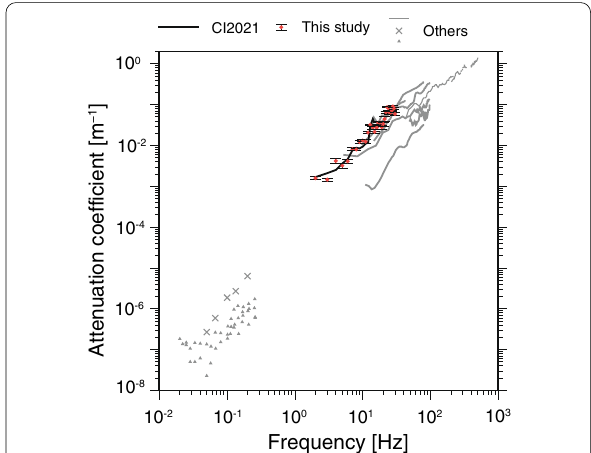
Fig. 13 Frequency characteristics of the attenuation coefficients. The analysis results of this study are indicated by red circles with error bars (standard errors). The solid black line indicates the analysis result of CI2021 at Tsukuba, Japan. The gray lines and marks indicate the analysis results obtained by other researchers (Fig. 12 of